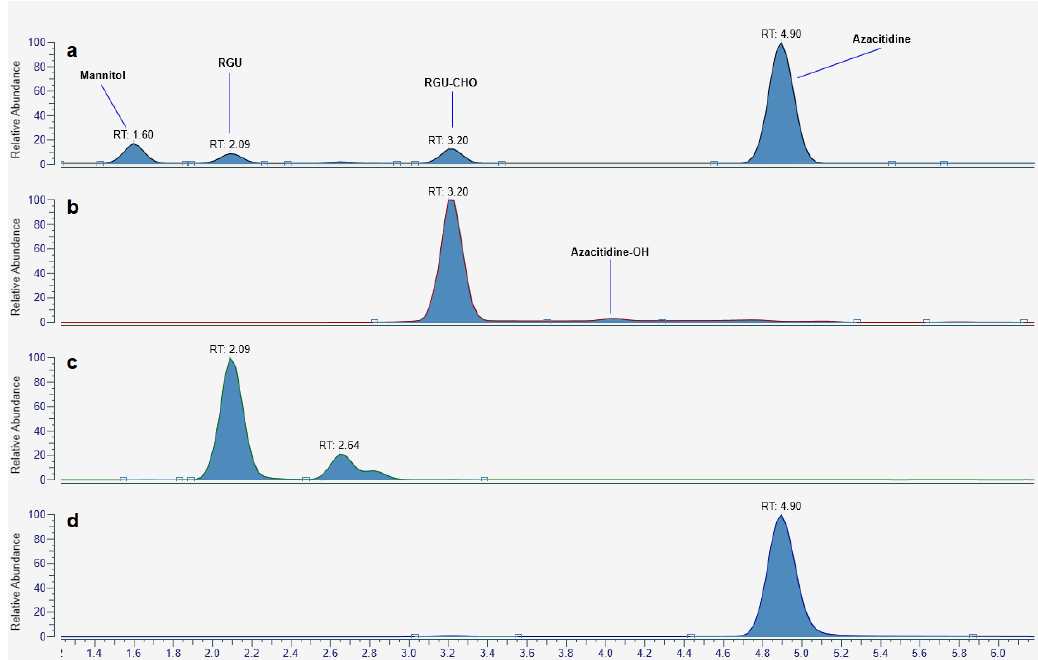
Figure 5. Typical ESI+ base peak chromatogram of a partially degraded azacitidine sample ( a ); extracted ion chromatogram ( m / z : 263.0986, corresponding to the protonated form of RGU-CHO), showing an additional peak at RT = 4 ′ , attributable to the hydrated form of azacitidine or an RGU-CHO tautomer ( b ); extracted ion chromatogram ( m / z : 235.1037, corresponding to the protonated form of RGU), showing two more peaks attributable to the two RGU tautomers at RT = 2.6 ′ ( c ); extracted ion chromatogram ( m / z : 245.0881, corresponding to the protonated form of azacitidine) ( d